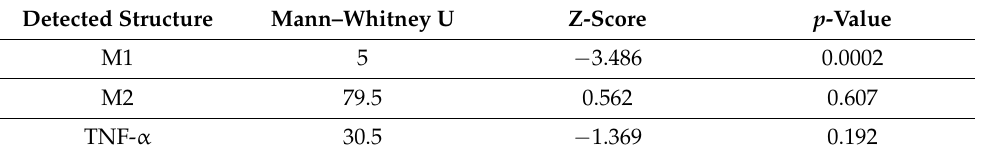
Table 3. The statistical significance of the distribution of factors between the patients’ group and control. Detected Structure